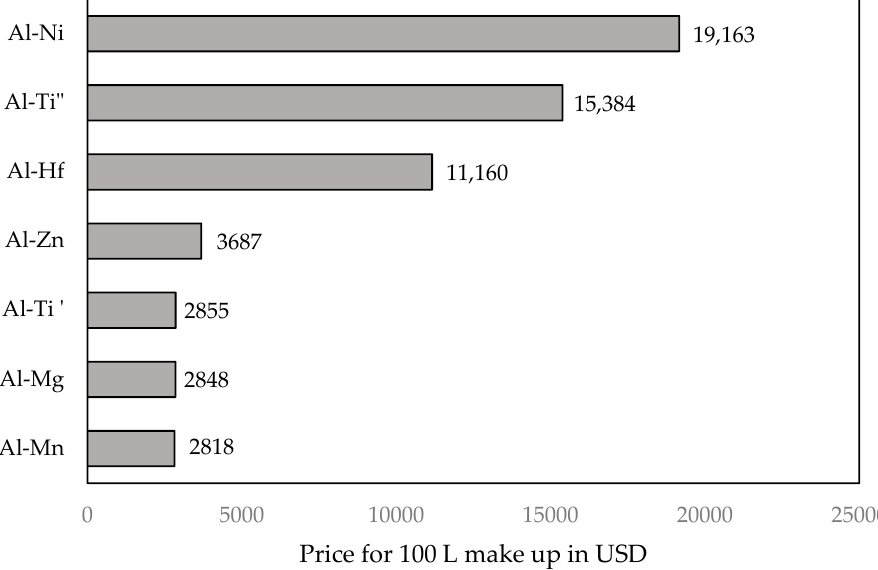
Figure 9. Plot showing the cost comparison of the ionic liquid-based systems for the deposition of Al-X alloys considering the initial make up of 100 L solution. Al-Ti’ represents the deposition of Al-Ti alloy from solution containing TiCl 2 and Al-Ti” represents the deposition of Al-Ti alloy from solution containing TiCl 4 .